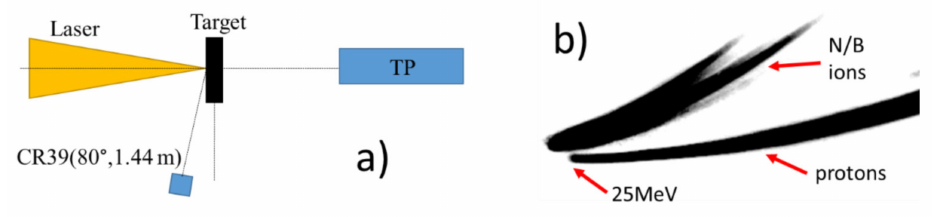
Figure 2. ( a ) The experimental setup; ( b ) the Thomson parabola (TP) snapshot showing the presence of protons and heavier ions being accelerated forwards from the target’s rear surface (TNSA acceleration mechanism), i.e., not contributing to the generation of α -particles via p–B